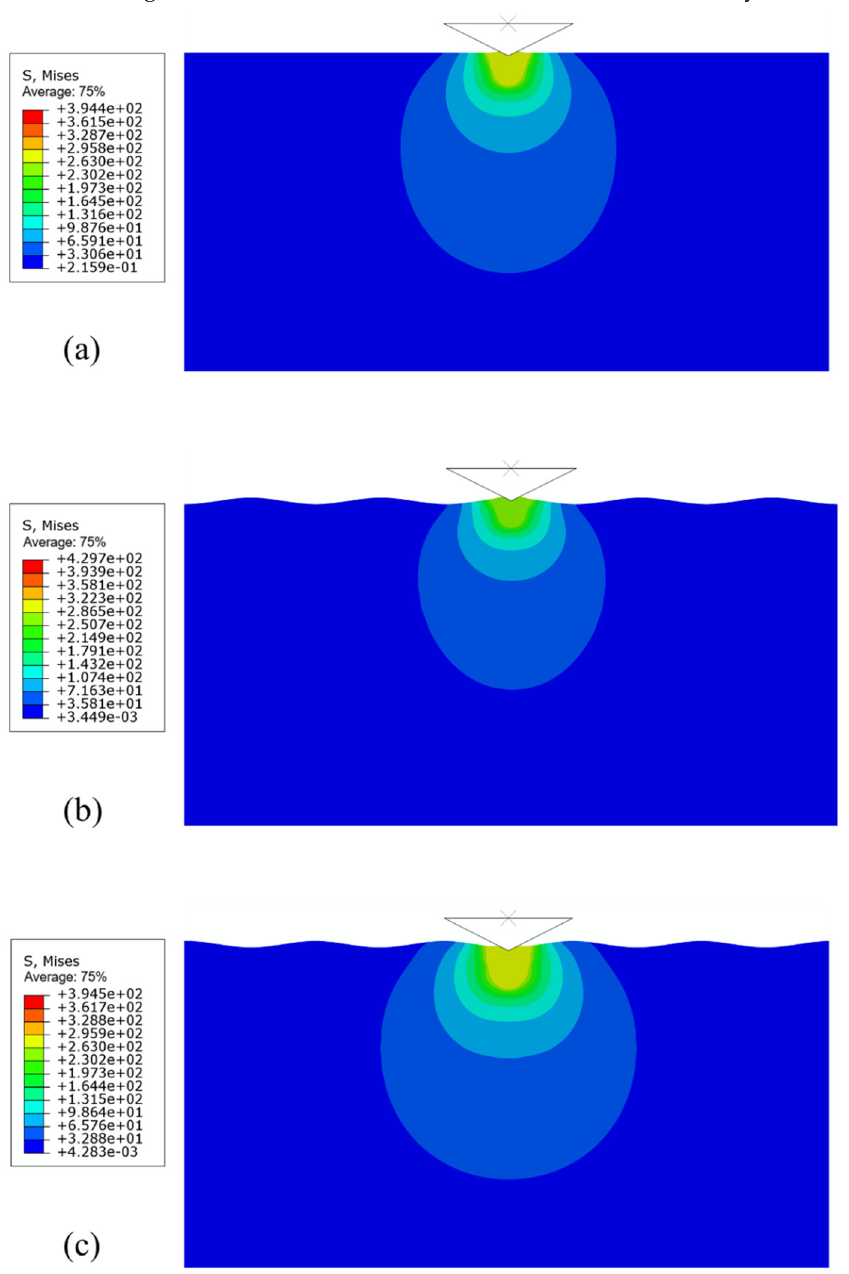
Figure 7. Stress distribution of different contact positions between indenter and sample. ( a ) plane; ( b ) crest; ( c ) trough.